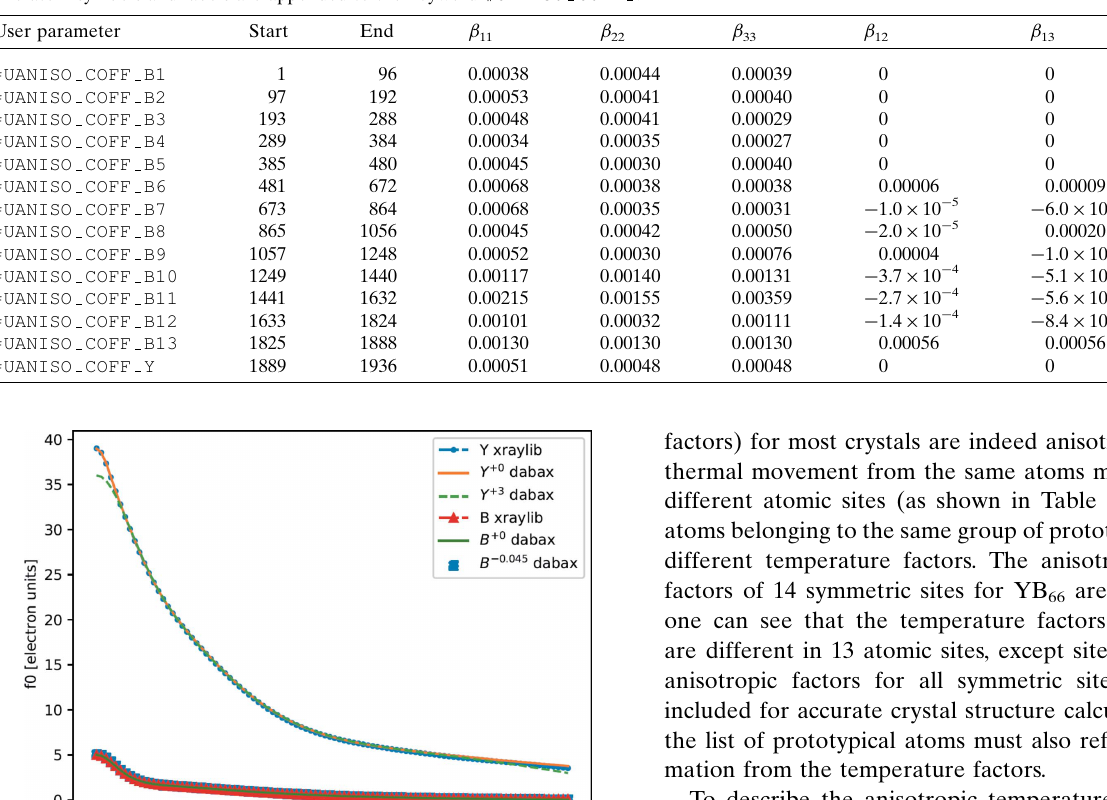
Table 2 Anisotropic parameters for the Debye–Waller factor for the prototypical atoms of YB 66 . The atom symbols and labels are appended to the keyword #UANISO COFF .